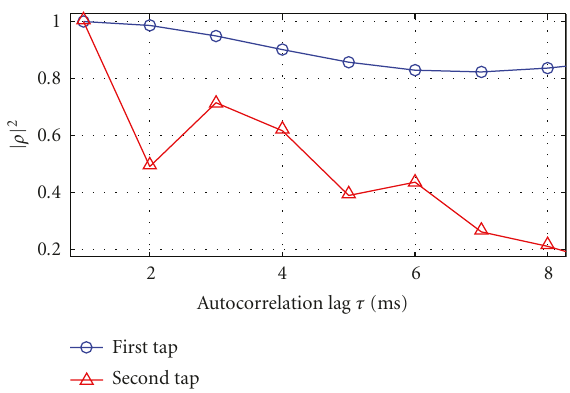
Figure 7: An example realization of Case 2 for the common parameter set defined in Section 3. The underlying processes are of Jakes’ and of GAUS1 type for the first and second taps, respectively.